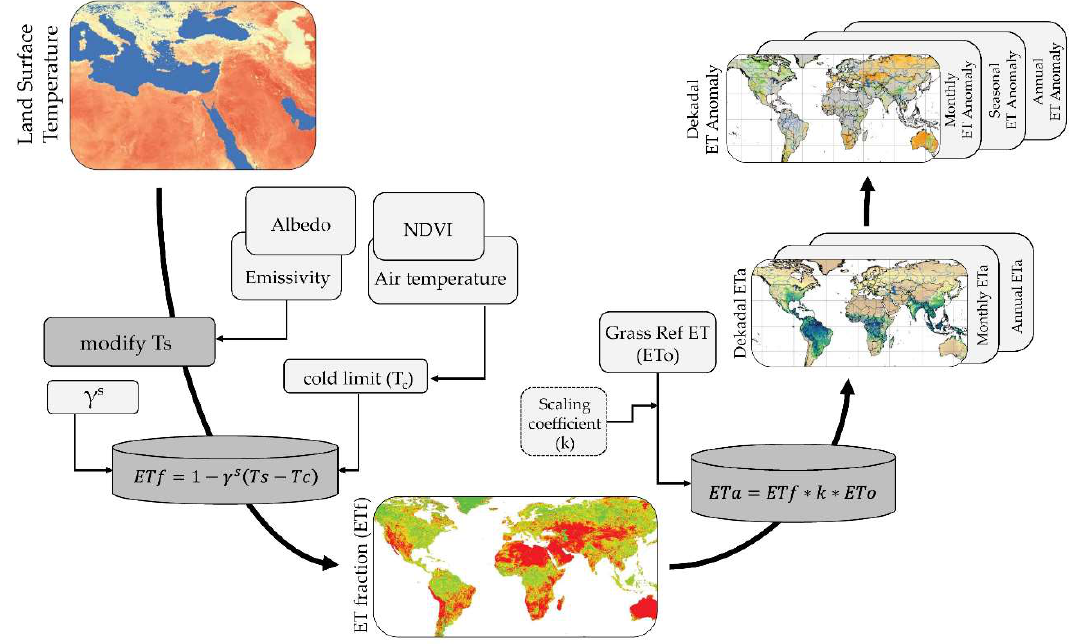
Figure 1. Overview of the SSEBop modeling process, adapted from Senay et al. [24], from the input data to the final products posted to the United States Geological Survey (USGS) Famine Early Warning Systems Network (FEWS NET) Data Portal (https://earlywarning.usgs.gov/fews/).